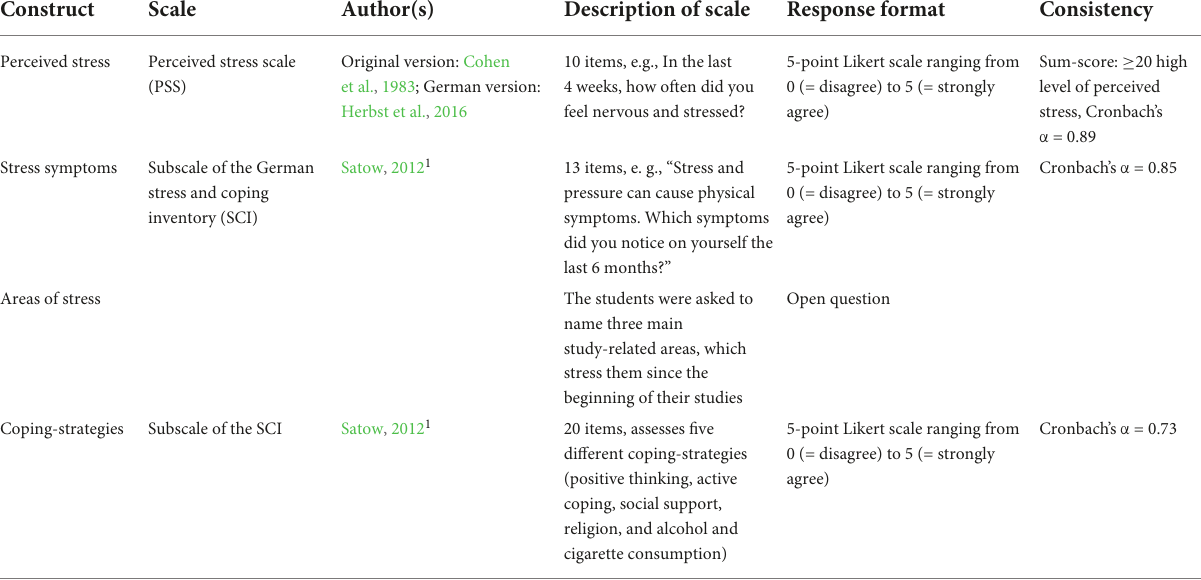
TABLE 2 Measures used for data collection.